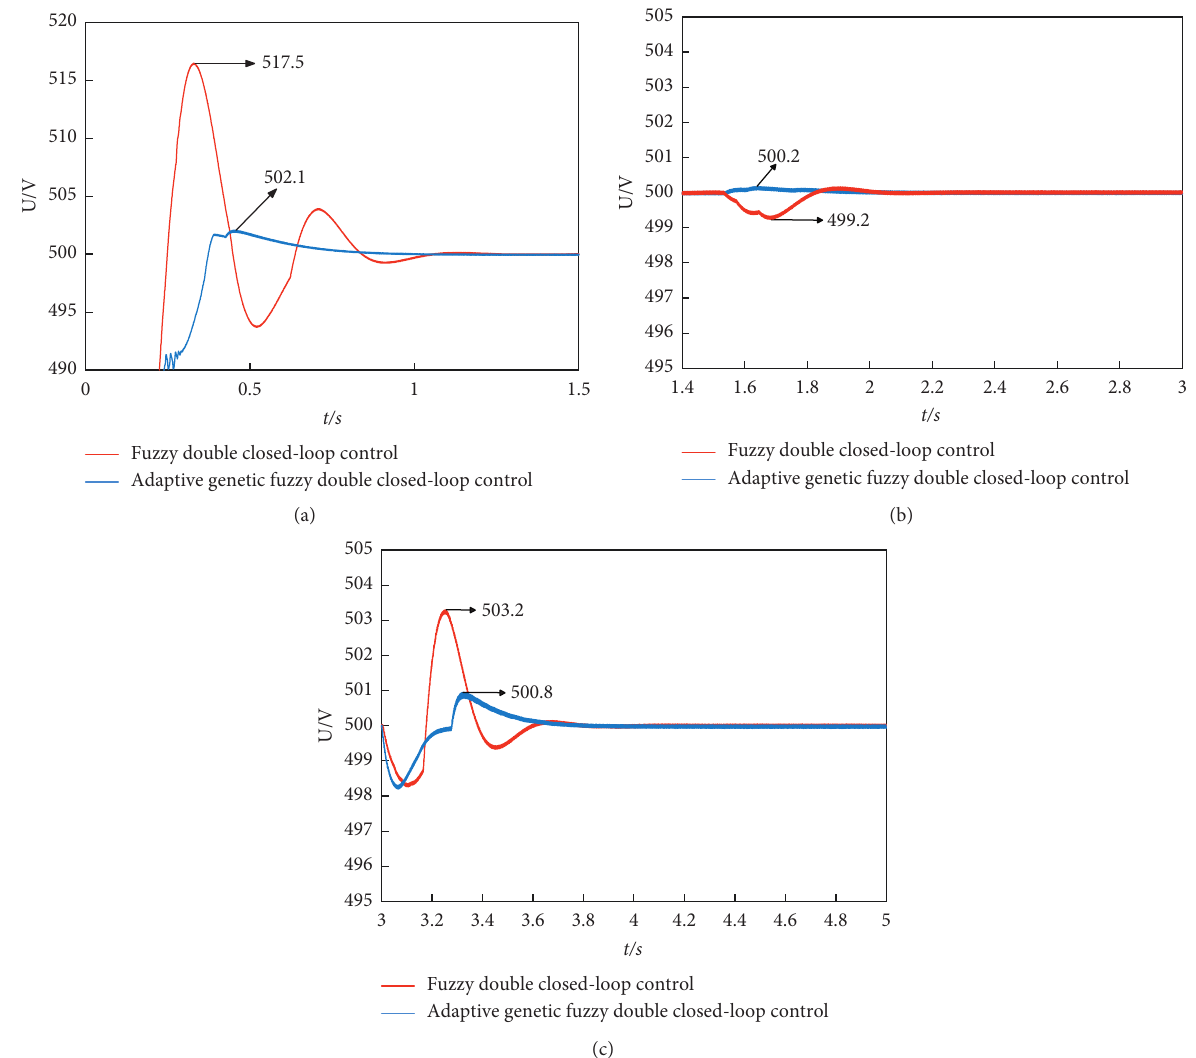
Figure 14: Voltage comparison of microgrid 1 bus. (a) Initial power-on. (b) Sudden increase of load. (c) A sudden drop in